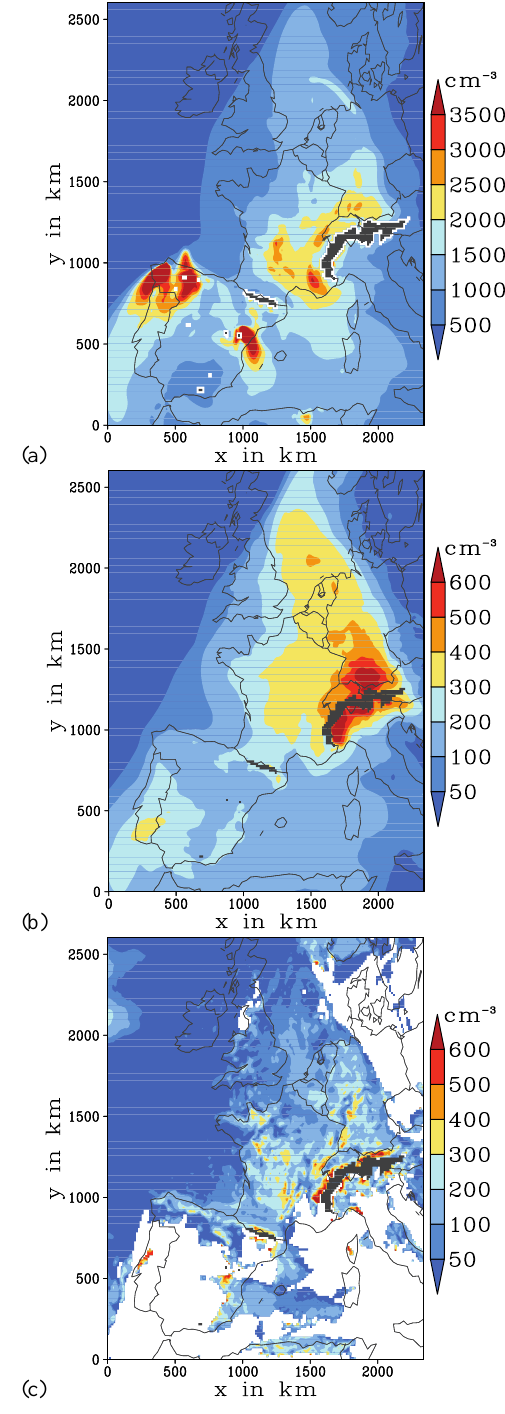
Fig. 4. Simulated spatial distributions (Simulation A) of (a) aver- age aerosol number concentration, (b) average CCN (0.1%) num- ber concentration and (c) average CDN concentration for the height interval 0 to 1500ma.s.l. and the time period 18–20 August